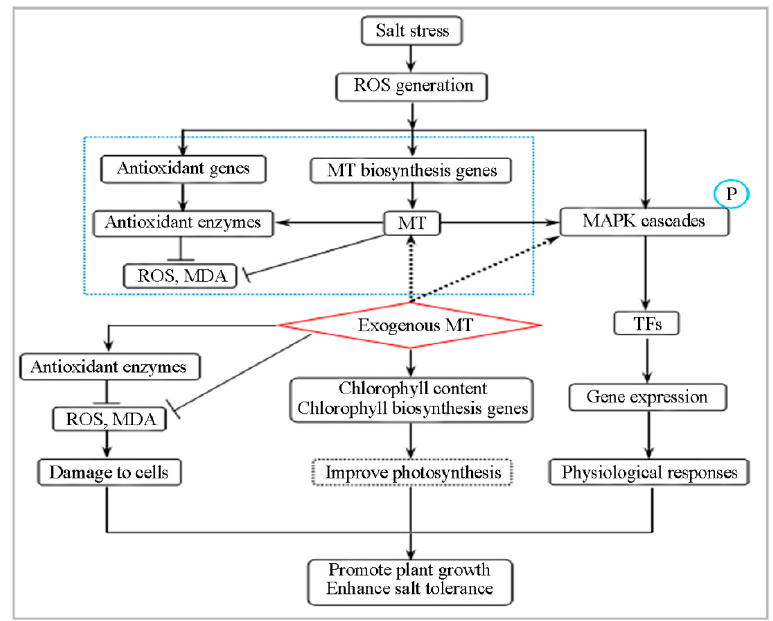
Figure 10. A model showing the potential mechanisms of melatonin (MT)-mediated alleviation in NaCl-caused oxidative stress of naked oat.